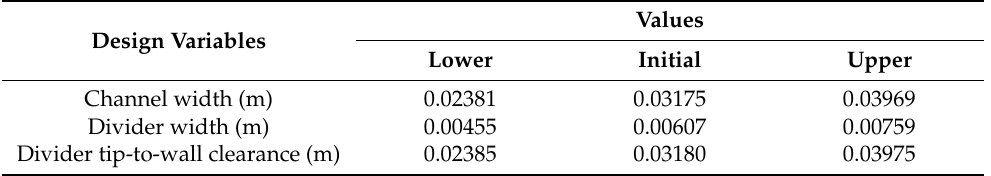
Table 2. Range of design